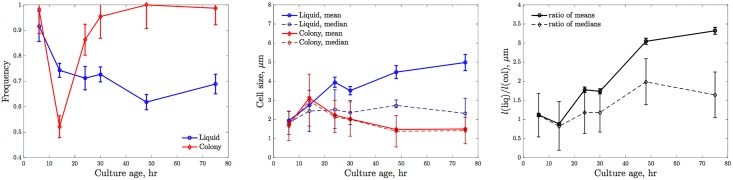
Cells in liquid and in colonies have different sizes.(Left) The fraction of non-filamentous cells (< 5 μm in length) in liquid cultures and in colonies. Color convention is as in the previous figures. Error bars represent the square-root counting statistics. (Center) The mean and the median cell sizes in liquid and colony cultures. Error bars of the means are s. e. m. Error bars of the medians are the bootstrapped 95% confidence intervals. (Right) The ratio of cell sizes in liquid to those in colonies. The solid line shows the ratio of the means, and the dashed line is the ratio of the medians. Error bars are propagated from the error bars of the means and the medians. Cells in old colonies are 1.6 to 3.4 times shorter than in old liquid cultures.